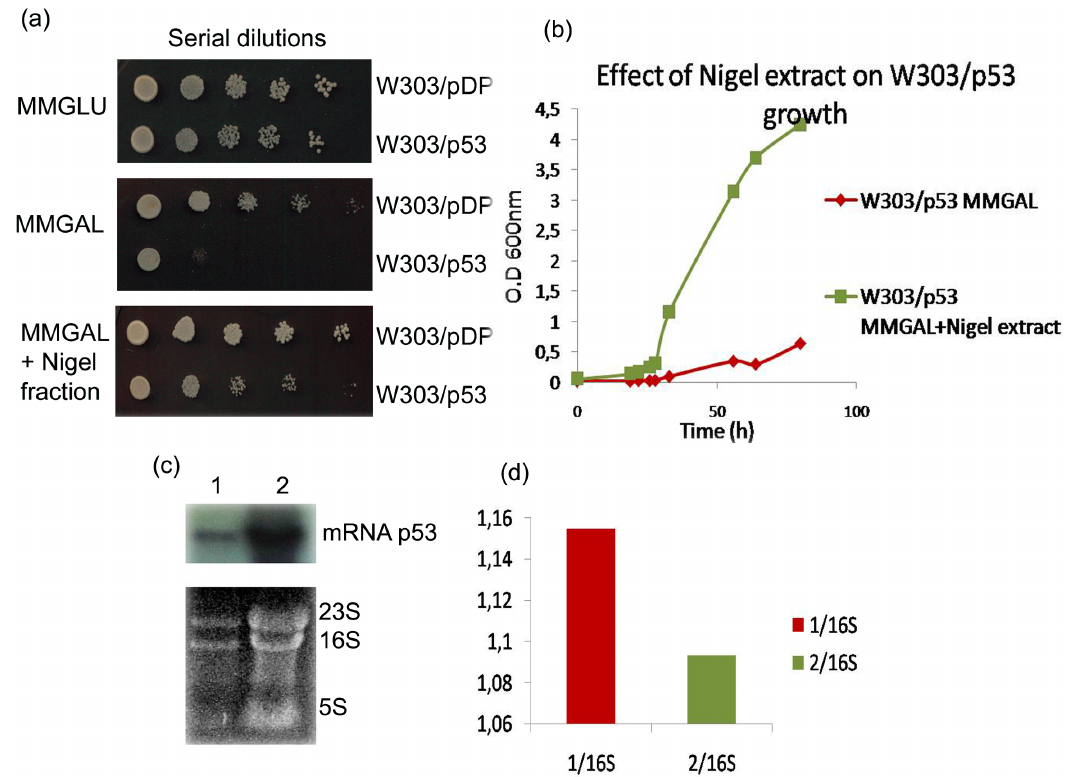
Fig 3. Effect of purified fraction from Nigel extract on the yeast growth of W303/p53. (a) Yeast clone W303/p53 growth on solid and (b) on liquidmedia MMGAL in absenceand presenceof purifiedNigel extract. And (c) northern blot analysisof p53 mRNA level in control cell W303/p53 in inducibleconditionin absence(1) and in presenceof Nigel extract (2).(d) Quantificationof the blot.